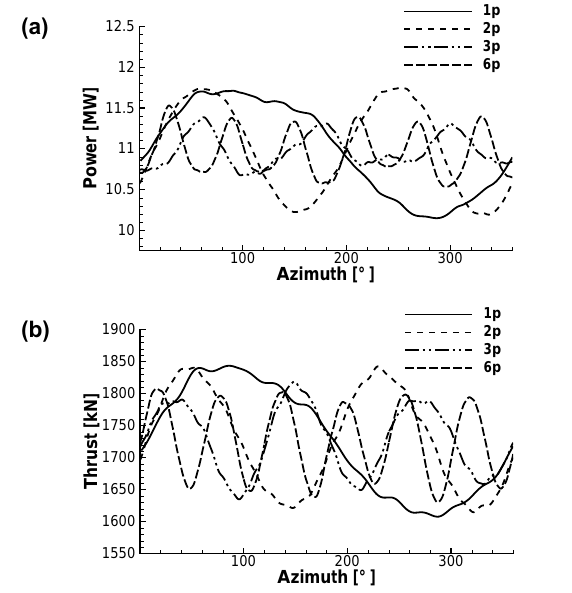
Figure 9. Integral rotor power (a) and thrust (b)